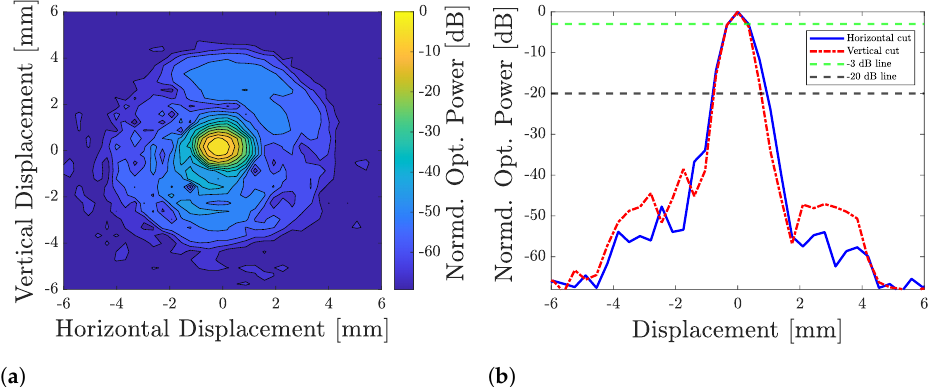
Figure 3. ( a ) SSMF contour map of power received at col2 for the different beam focus. ( b ) SSMF respective power penalty of beam misalignment.